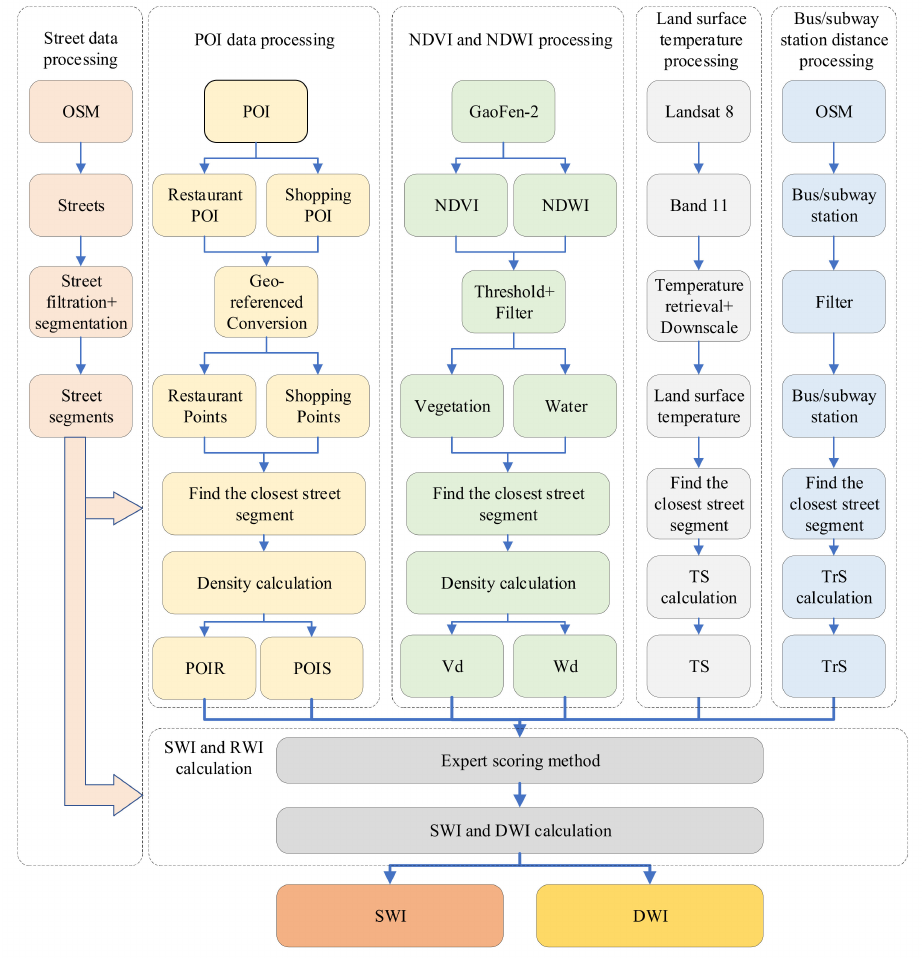
Figure 2. Flow chart of walking index